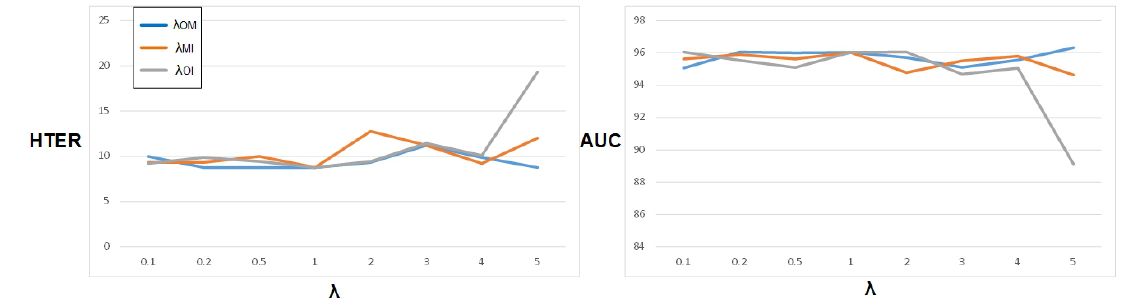
Figure 5. The impact of the alignment weights on the overall generalization performance was evaluated using the O&M&I to C protocol. The x-axis represents the value of λ . λ is the coefficient in the formula L Mdalign = alignment loss, and the control variable method was applied in the experiment, where only one λ was adjusted while the remaining parameters were kept constant. The left figure illustrates variations in the half total error rate (HTER), while the right figure shows the corresponding changes in the area under the curve